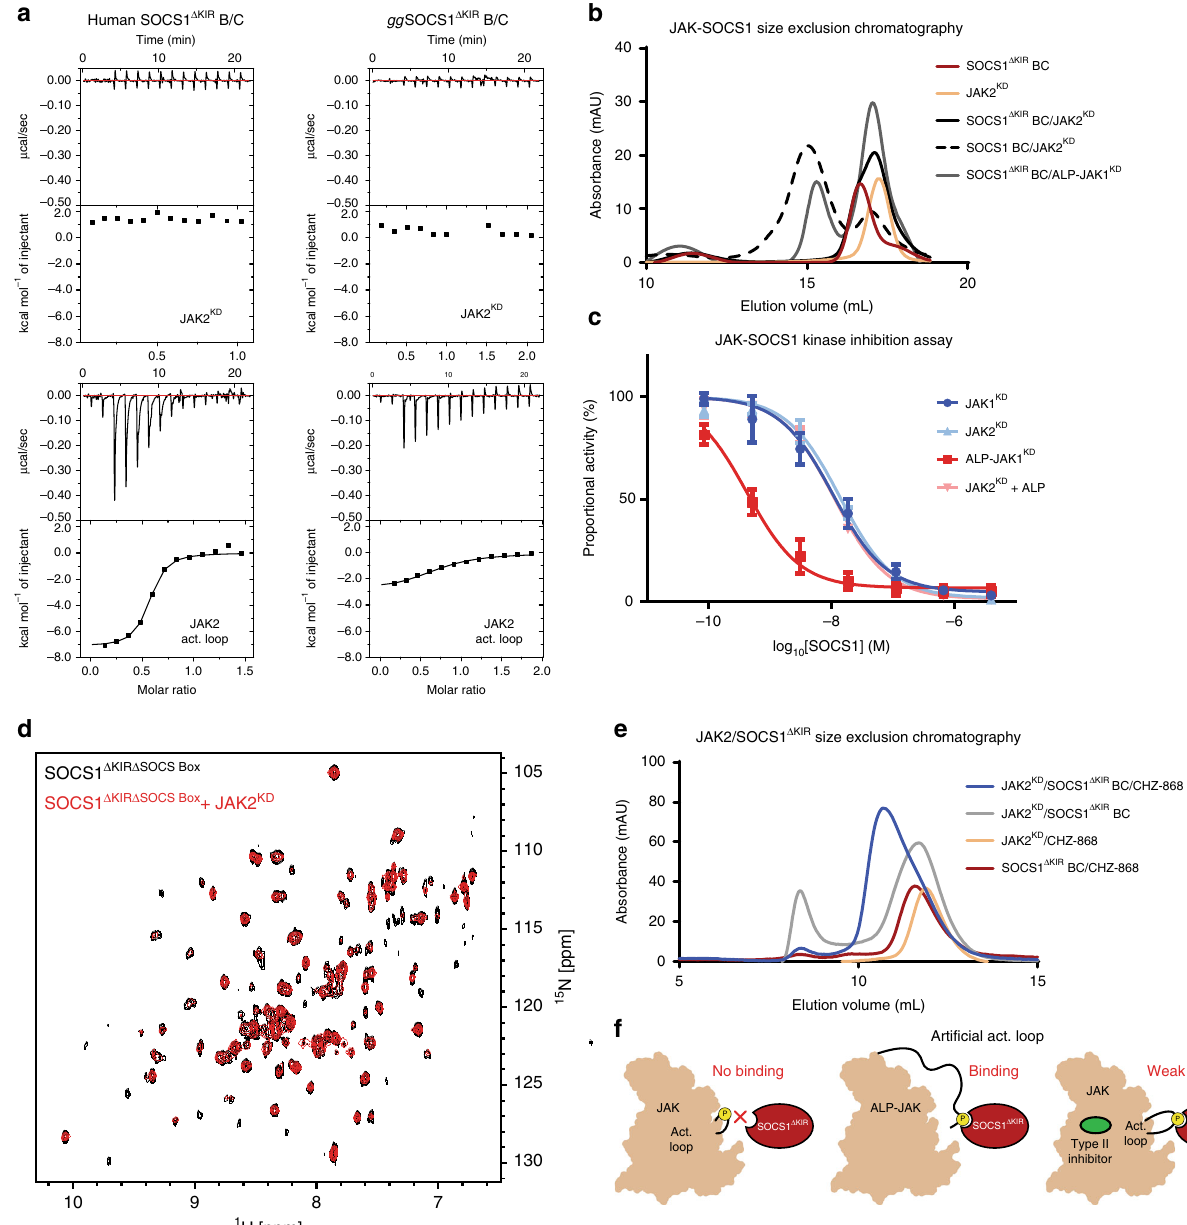
Fig. 7 Steric hindrance prevents SOCS1 from binding the JAK activation loop in the intact kinase domain. a ITC binding data indicates both human SOCS1 Δ KIR B/C (left) and gg SOCS1 Δ KIR B/C (right) do not bind to the JAK2 kinase domain but do bind to JAK2 activation loop peptides. b Size exclusion chromatography (using a Superdex 200 10/300 column) data indicate that SOCS1 Δ KIR B/C does not form a complex with JAK2. As positive controls, wild- type SOCS1 B/C does form a complex with JAK2, while SOCS1 Δ KIR B/C does form a complex with JAK1 when the activation loop peptide (ALP) motif is arti fi cially fused to the N-terminus of JAK. (ALP-JAK1 KD ). c Kinase inhibition assays show that SOCS1 inhibits JAK2 with similar IC 50 values in the absence and presence of activation loop peptide. Conversely, SOCS1 displays a lower IC 50 against ALP-JAK1 KD . Error bars represent the range of the data from two technical replicates. d NMR data indicate that gg SOCS1 Δ KIR Δ SOCSbox does not bind the phosphorylated JAK2 kinase domain. 1 H – 15 N SOFAST HMQC spectra of 15N-labelled gg SOCS1 Δ KIR Δ SOCSbox in the presence (red) and absence (black) of the phosphorylated JAK2 kinase domain (unlabelled) are shown overlaid. e Size exclusion chromatography data (using a Superdex 75 10/30 column) indicate that SOCS1 Δ KIR B/C forms a complex with JAK2 in the presence of 5 µ M CHZ-868 Type II inhibitor, but not in its absence. f Schematic summary of SOCS1 SH2 domain interactions. Under normal conditions, SOCS1 Δ KIR does not bind to the JAK activation loop due to steric hinderance. In the presence of a Type II inhibitor, the SOCS1 SH2 domain